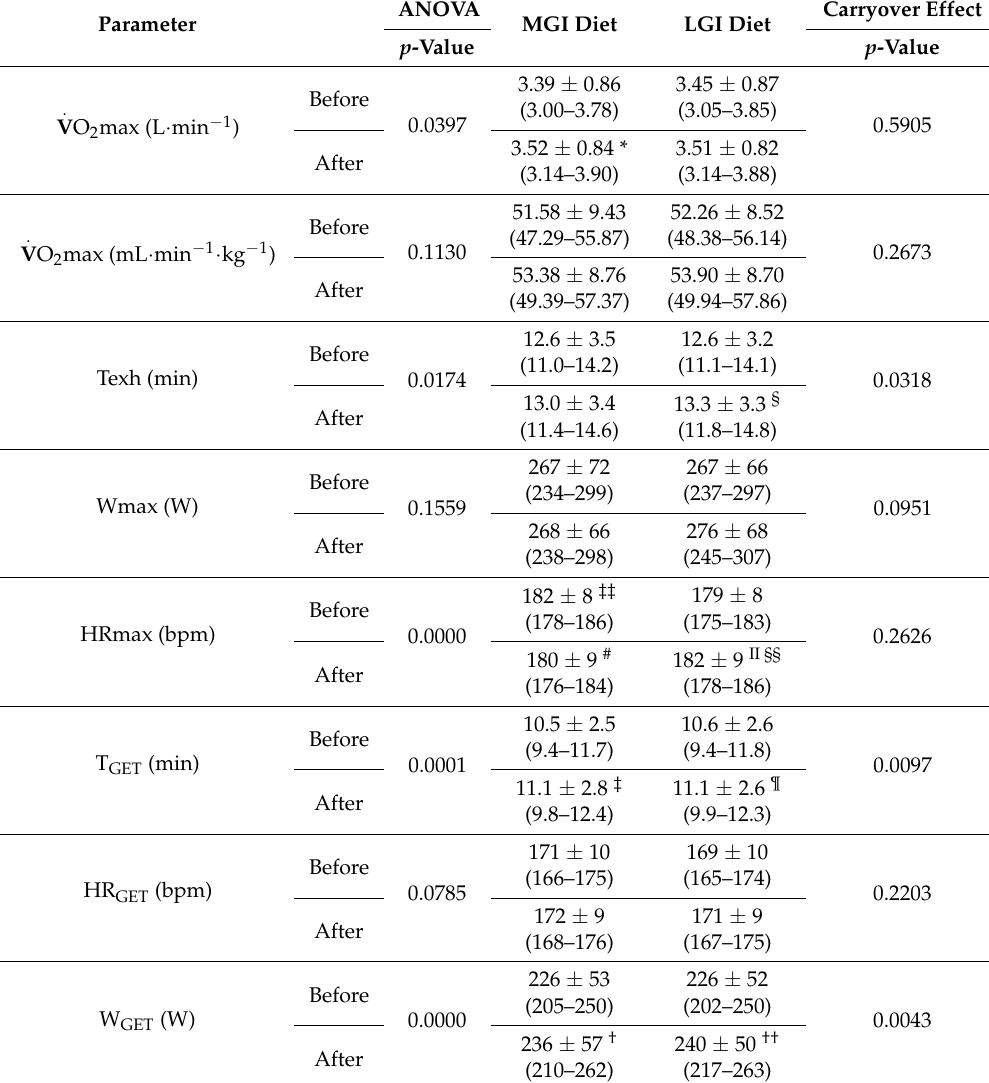
Table 3. Aerobic capacity indices before and after the three-week MGI and LGI